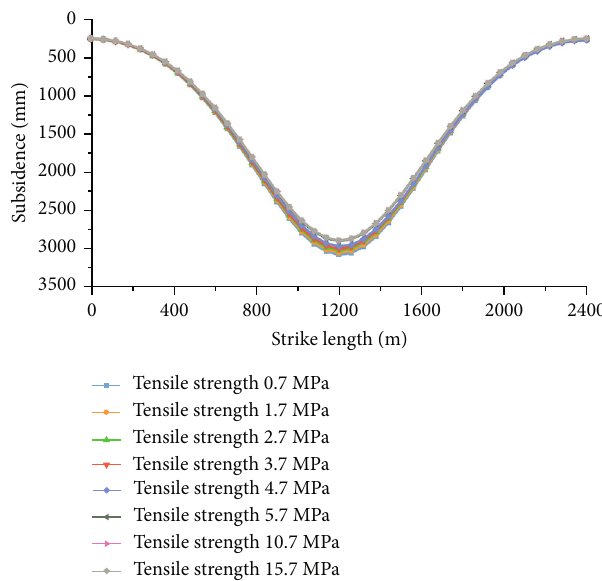
Figure 14: Surface subsidence curve of di ff erent tensile strength in strike